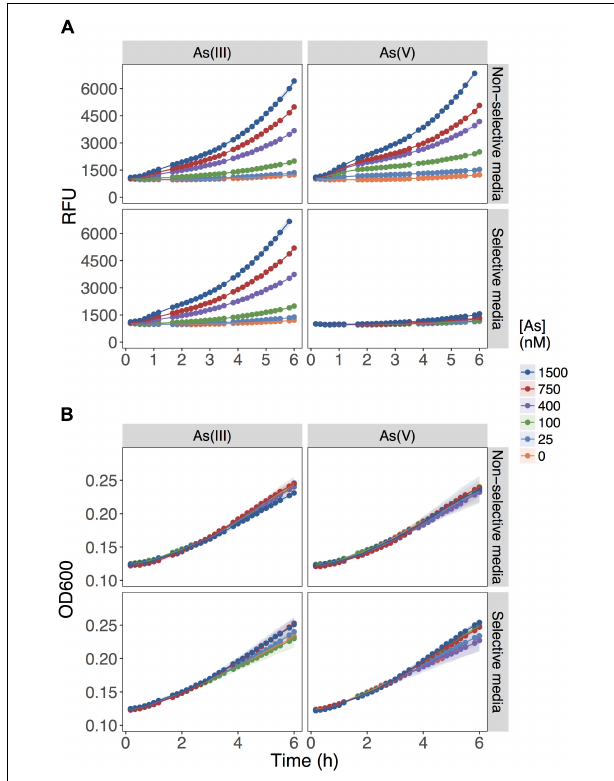
FIGURE 1 | Role of inorganic phosphate addition in detection of As(III) and As(V). (A) Biosensor was exposed to the indicated concentrations of As(III) or As(V) in MGP media lacking inorganic phosphate (non-selective media) or MIP media containing 10 mM inorganic phosphate (selective media). The output signal of the biosensor is presented in relative fluorescence units (RFU) during the first 6 h of growth immediately following exposure to arsenic. (B) The optical densities of biosensor cultures at 600 nm (OD 600 ) are shown, indicating similar growth rates for the cultures in both exposure